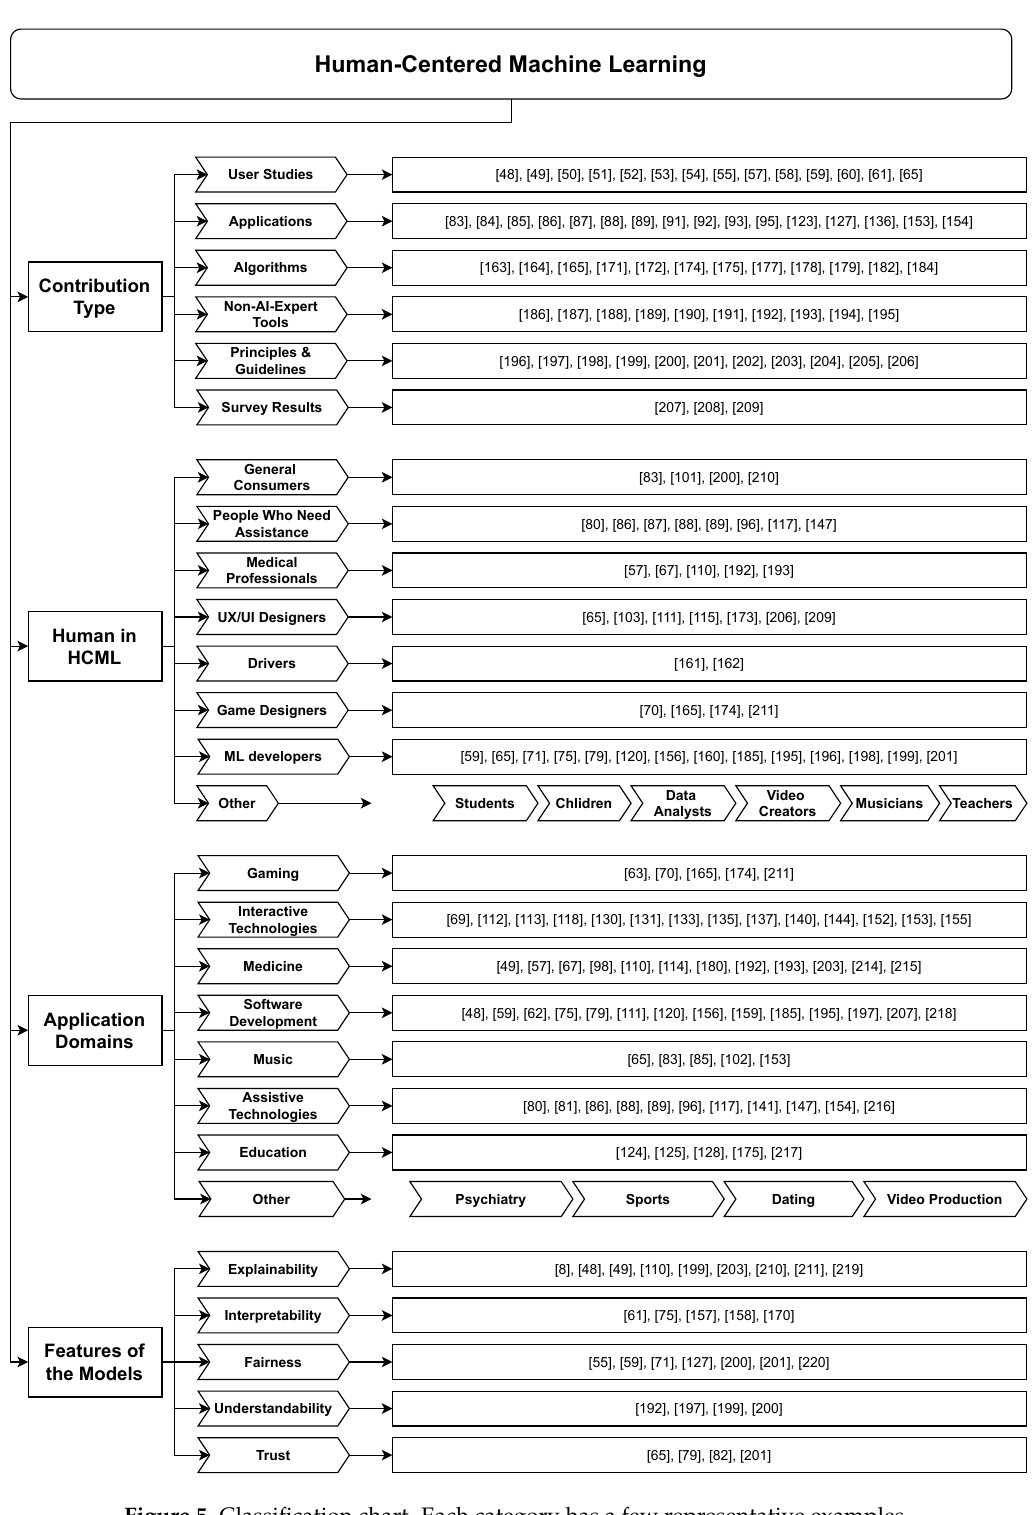
Figure 5. Classification chart. Each category has a few representative